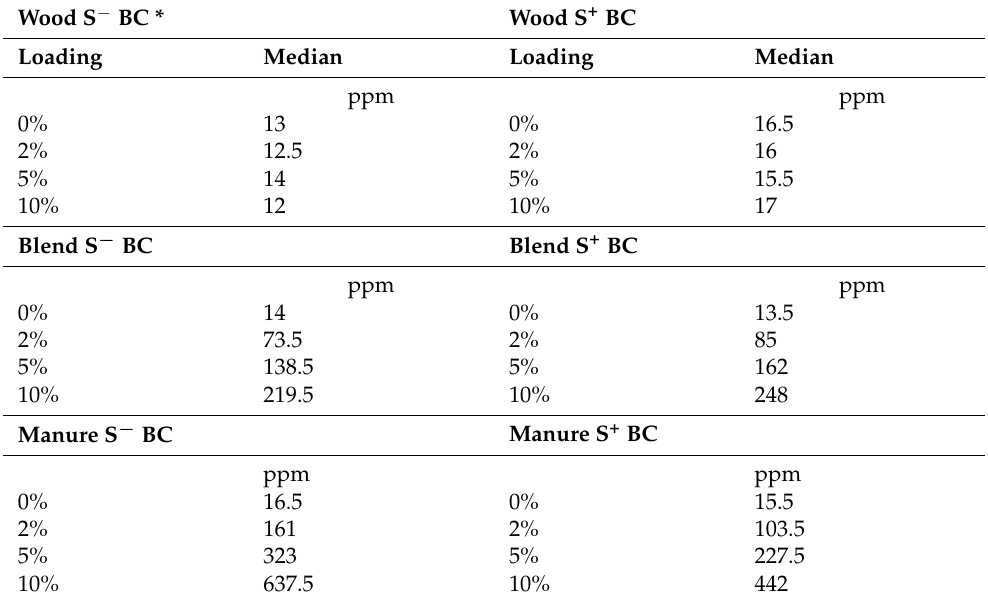
Table 11. Soil phosphorus ppm median values for pots growing Trifolium incarnatum . Wood S − BC * Wood S + BC